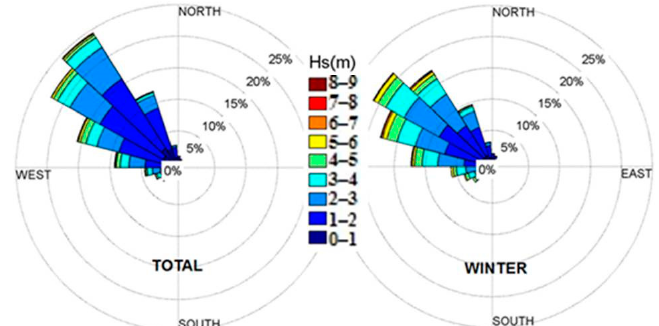
Figure 3. Analysis of the wave conditions in the vicinity of the external boundary of the local computational domain (Level III) (39.8° N, 9.75° W), corresponding to eight ‐ year of model system simulations (2005–2012). Directional distribution of significant wave height, structured in total and winter time, respectively.